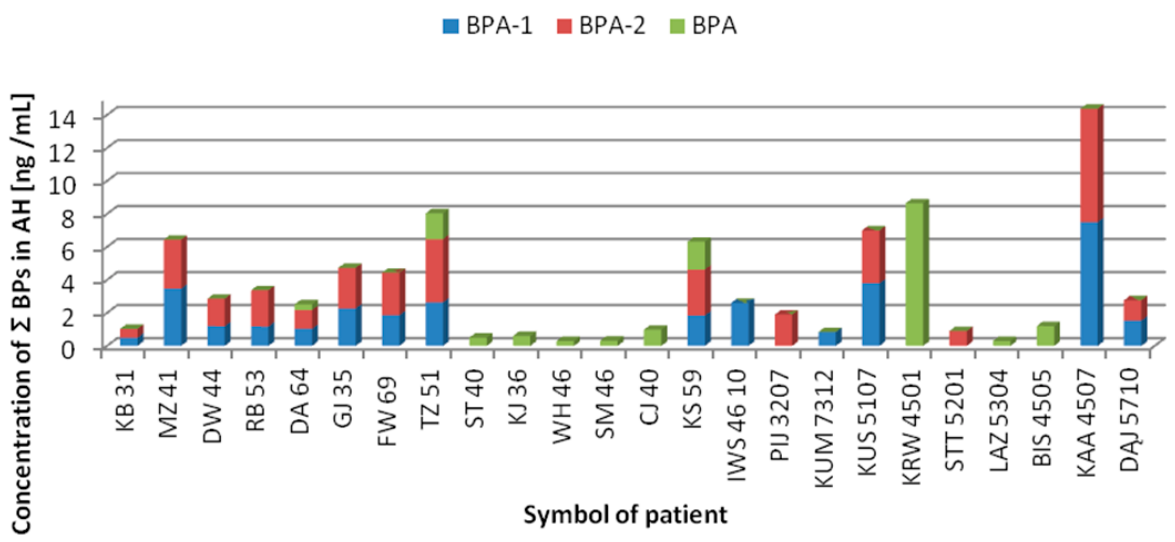
Figure 5. Stacked bar charts dividing each bar into subcategories representing the concentration of BPA-free, and its structural isomers BPA-1, BPA-2 in AH of patients undergoing cataract surgery.